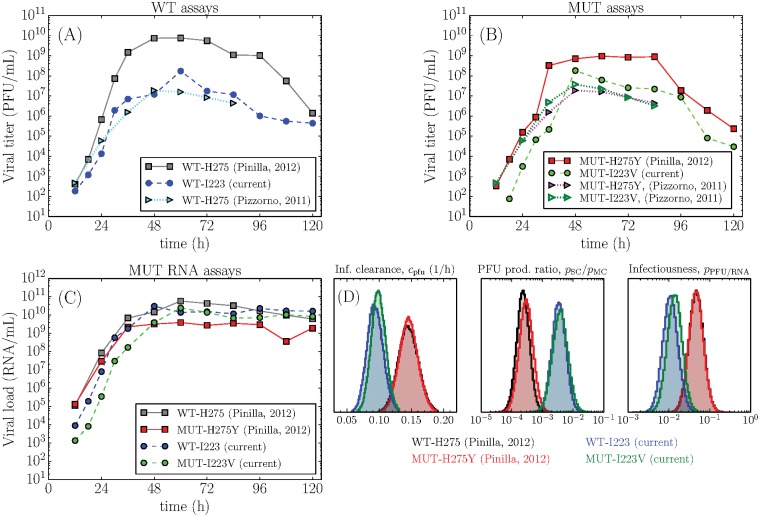
Differences between inter-experimental replicates.(A) Infections with the same H1N1pdm09 wild-type strain illustrate that viral titer growth rates, peak values, and decay rates can vary noticeably between three experiments performed on different dates. (B) Infections with either the MUT-H275Y or the MUT-I223V single mutants over two separate experiments. The peak viral titers are more similar to the wild-type performed in the same experiment (comparing to left graph), than within the same strain in different experiments. (C) Recorded RNA titers either from the current study or previously presented (Pinilla, 2012 in [18], Pizzorno, 2011 in [34]) and reproduced here for comparative purposes. (D) Probability density functions of parameters for the WT and mutant pair of strains in either the current (blue, green) or previous (black, red) experiment illustrate that some infection parameters are clearly more experiment-specific than strain-specific, pointing to a genuine impact of inter-experimental variability on the actual viral replication parameters.